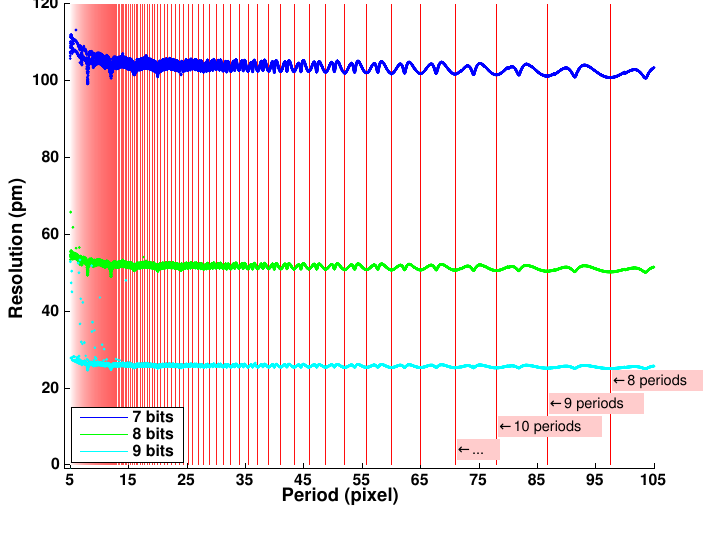
Figure 9. Ultimate resolution in picometers as a function of grid period and quantization depth (At each period, maximum error observed on 10 3 positions shifted by 10 − 6 pixel, with a grid of period 8